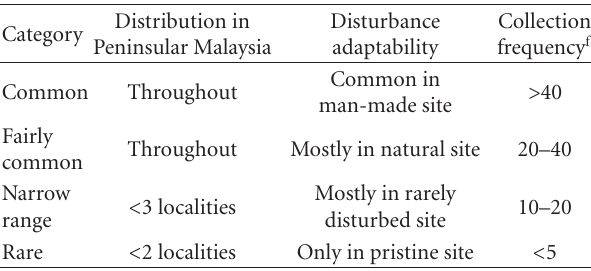
Table 3: Commonness criteria ∗ for Utricularia of Peninsular Malaysia.